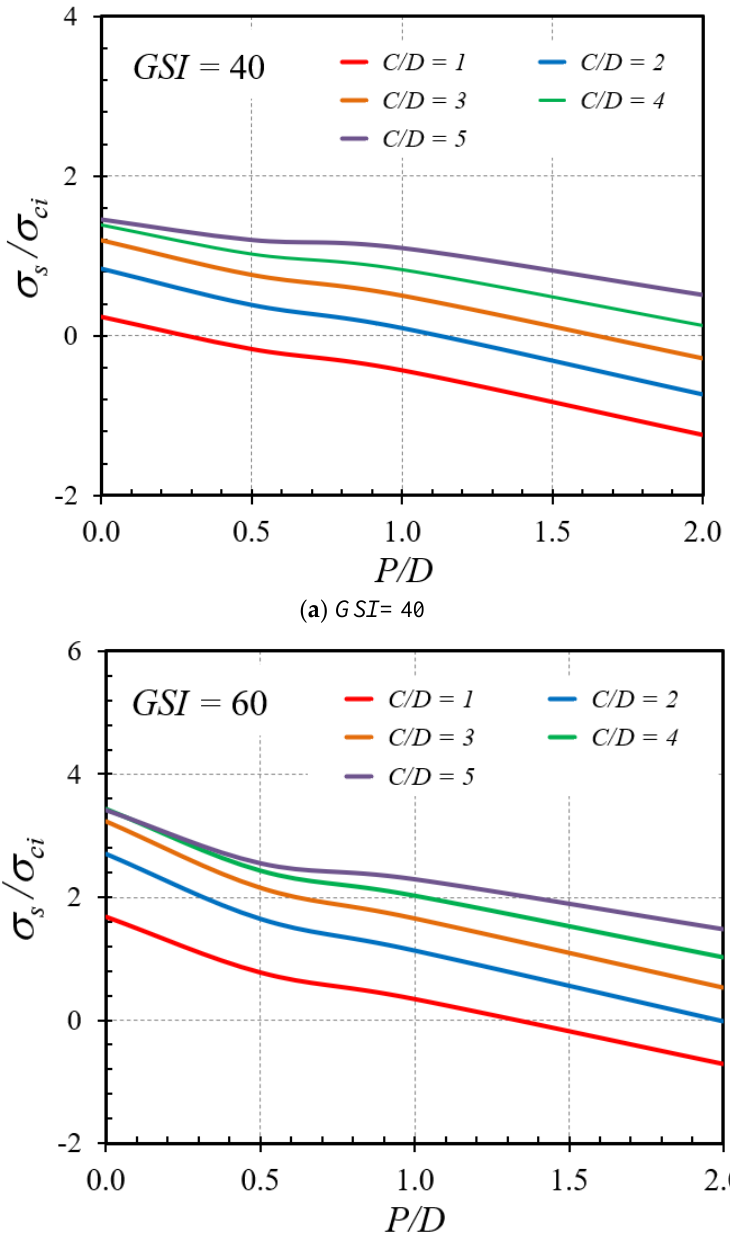
Figure 10. Impact of P/D on the stability solutions of tunnel headings ( γ D/ σ ci = 0 and m i = 5).